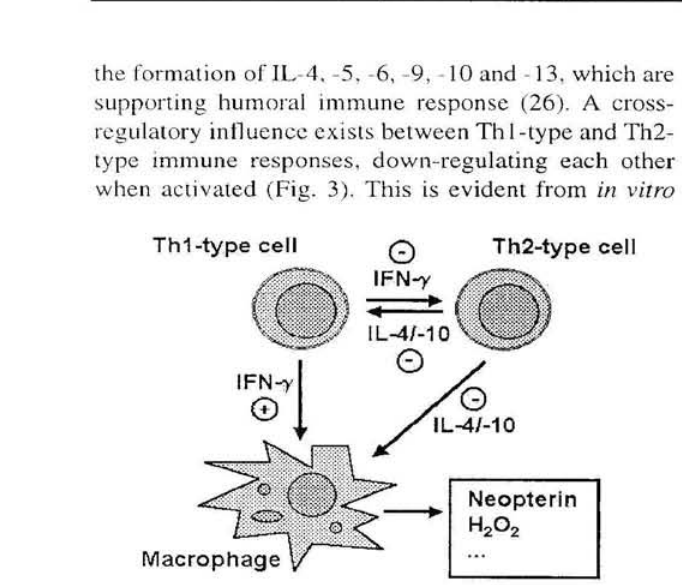
Figure 3: During activation of Thl-type immune response in humans and primates, cytokine interfe- ron-γ (IFN-γ) stimulates macrophages to produce neopterin derivatives in parallel to reactive oxygen species such as H 2 0 2 . Thl-type cytokines down-regu-